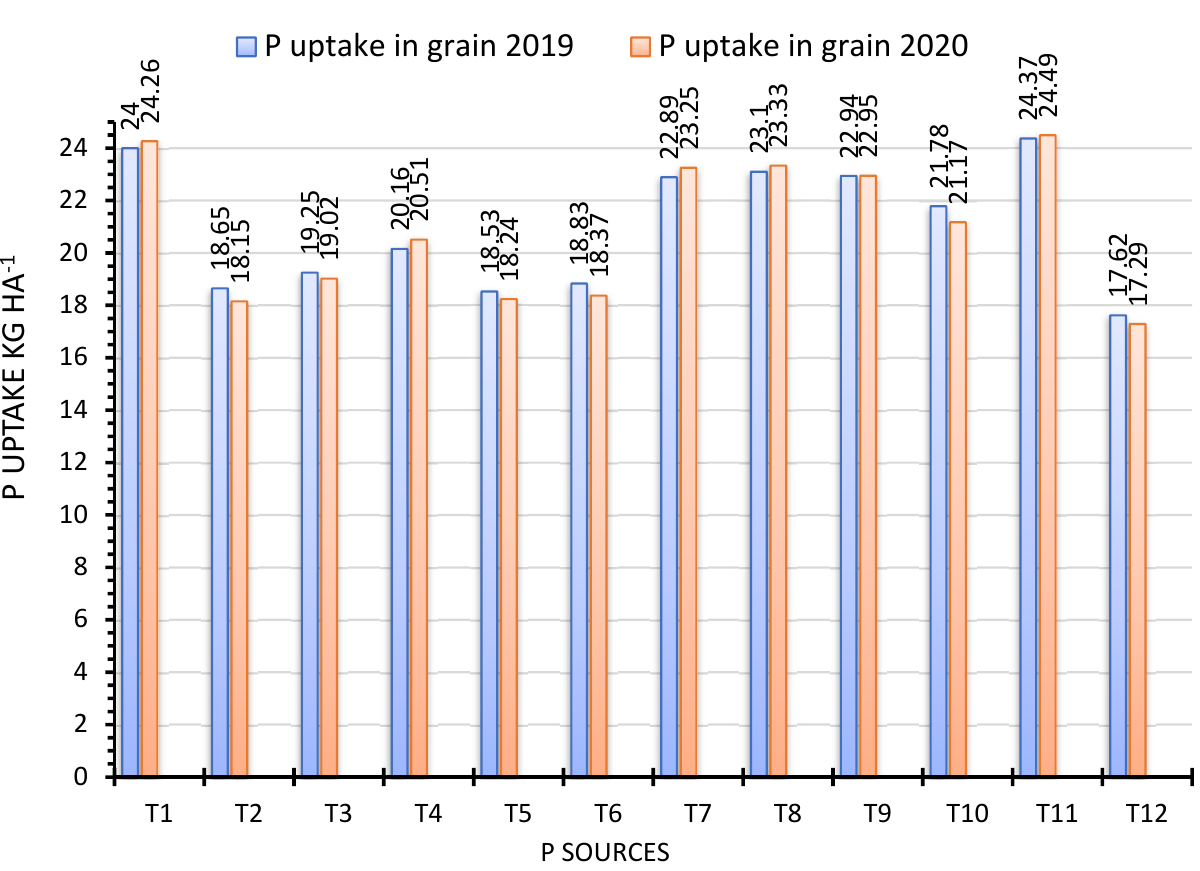
Figure 2. Phosphorus uptake in grain of Sakha 106 rice cultivar was affected by arbuscular my- corrhizal fungi, phosphate-solubilizing bacteria and selected chemical phosphorus fertilizers in the 2019 and 2020 seasons. SSP, single super phosphate (15% P 2 O 5 ); PSBs, phosphate-solubilizing bacteria; AMFs, arbuscular mycorrhizal fungi; PNPs, phosphorus nanoparticles; PA, phosphoric acid. T1, basal application of 100% single super phosphate (SSP) (P 1 ); T2, basal application of 75% SSP (P 2 ); T3, P 2 + top-dressing with phosphate-solubilizing bacteria (PSBs); T4, P 2 + top-dressing with arbuscular mycorrhizal fungi (AMFs); T5, P 2 + foliar spraying of phosphorus nanoparticles (PNPs); T6, P 2 + foliar spraying of phosphoric acid (PA); T7, P 2 + top-dressing with PSBs + AMFs; T8, P 2 + foliar spraying of (PSBs + PNPs); T9, P 2 + foliar spraying of (PSBs + PA); T10, P 2 + foliar spraying of (PNPs + PA); T11, P 2 + foliar spraying of (PSBs + PNPs + PA); T12, zero-phosphorus fertilizer (Control).